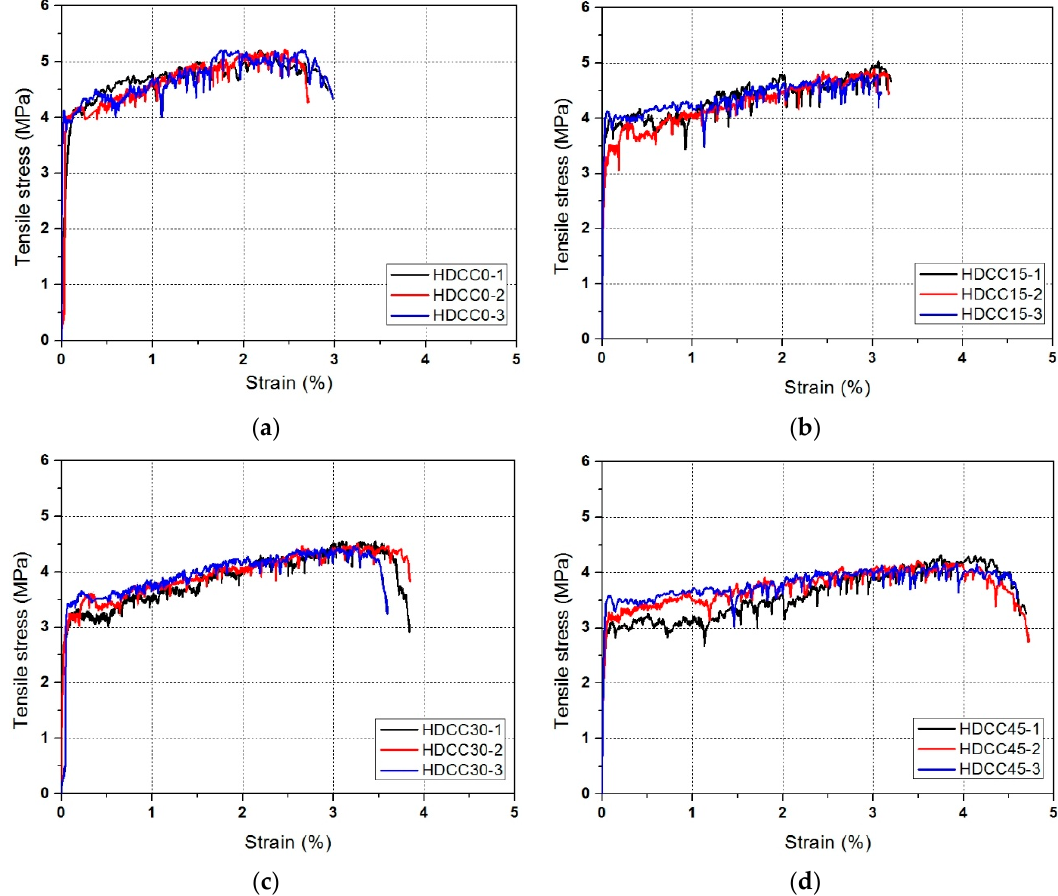
Figure 4. Tensile stress-strain curves in uniaxial tension: ( a ) HDCC0; ( b ) HDCC15; ( c ) HDCC30; and ( d ) HDCC45. Table 3. Result of uniaxial tensile test.